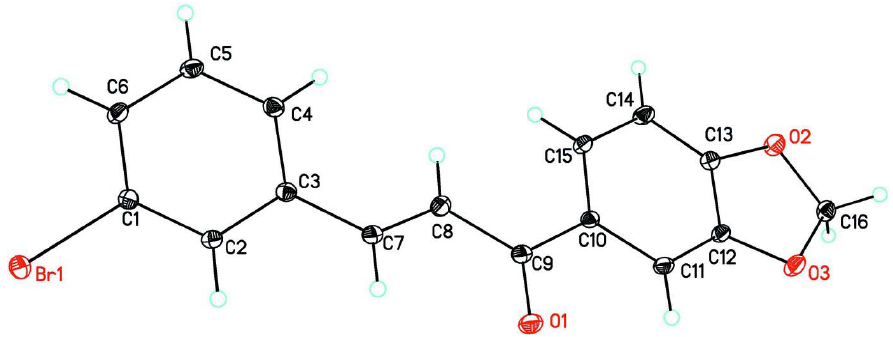
Molecular structure of the title compound with displacement ellipsoids drawn at the 30% probability level for non-H